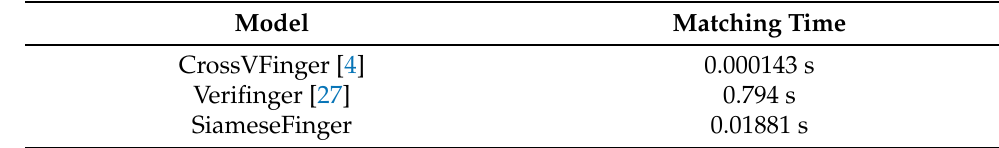
Table 6. Comparison of SiameseFinger, CrossVFinger [4] and Verifinger